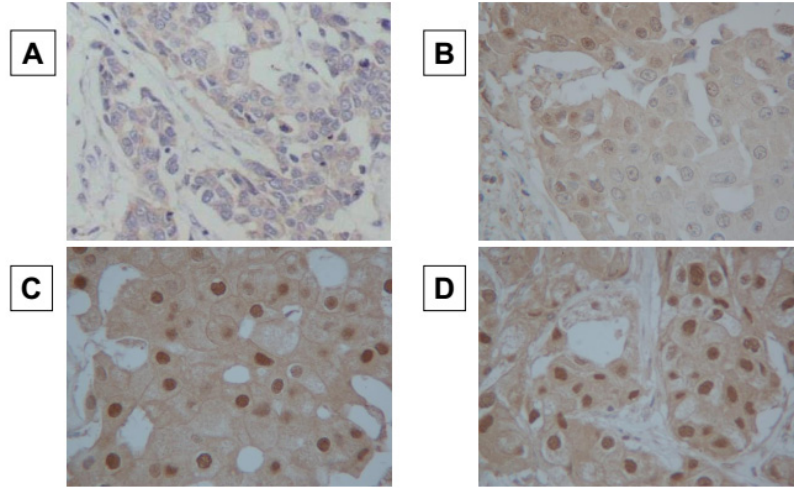
Figure 1. Immunohistochemical determination of androgen receptor. Androgen receptor (AR) expression was semi-quantitatively analyzed according to the percentage of cells showing nucleus tipositivity: 0, 0% ( A ); 1+, 1%–29% ( B ); 2+, 30%–69% ( C ); 3+, ≥ 70% ( D ). AR expression was considered positive when scores were ≥ 1, and negative when scores were 0. ( ×